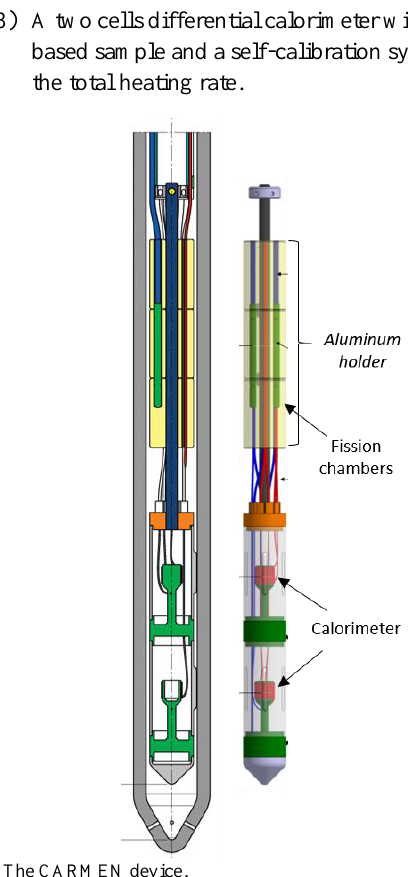
Fig. 4. The CARMEN